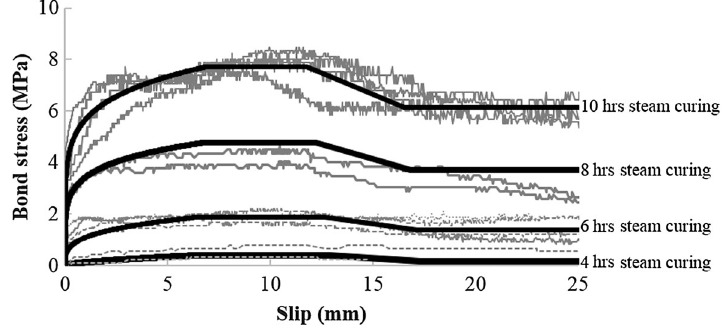
Fig. 9 Comparisons between model predictions and test results on bond stress–slip relationships.